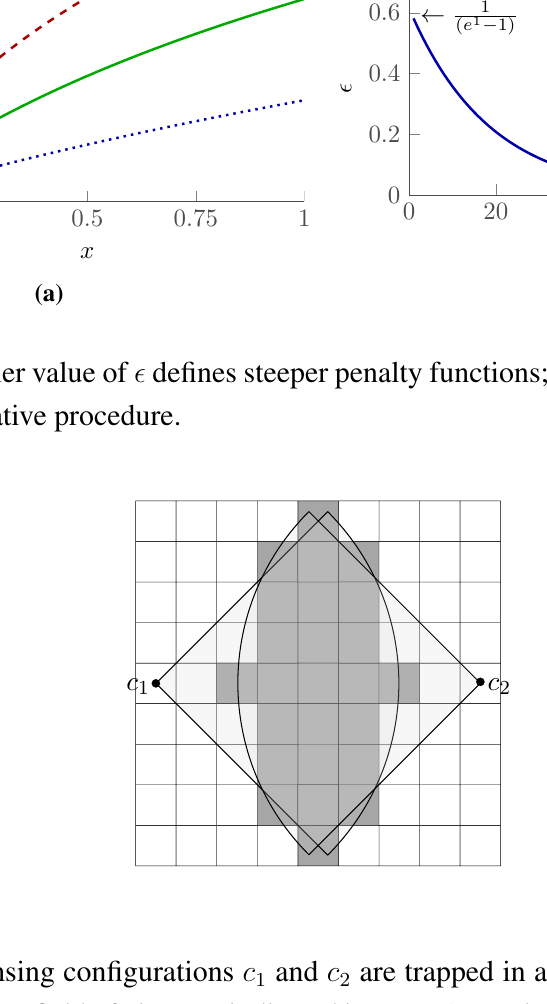
and c are trapped in a local minimum. The cells 1 2 and c are set to 0 . 5 in 1 2